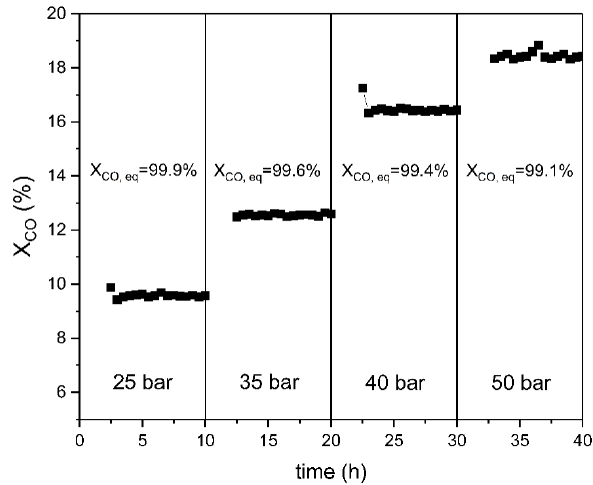
Figure 10. Conversion of CO in the presence of hydrogen over 0.3Pt / CoAl catalyst at 220 ◦ C. Reaction conditions: W cat = 0.2 g, F H2O = 0.04 mL / min, F CO = 3.5 mL / min, F H2 = 14 mL /